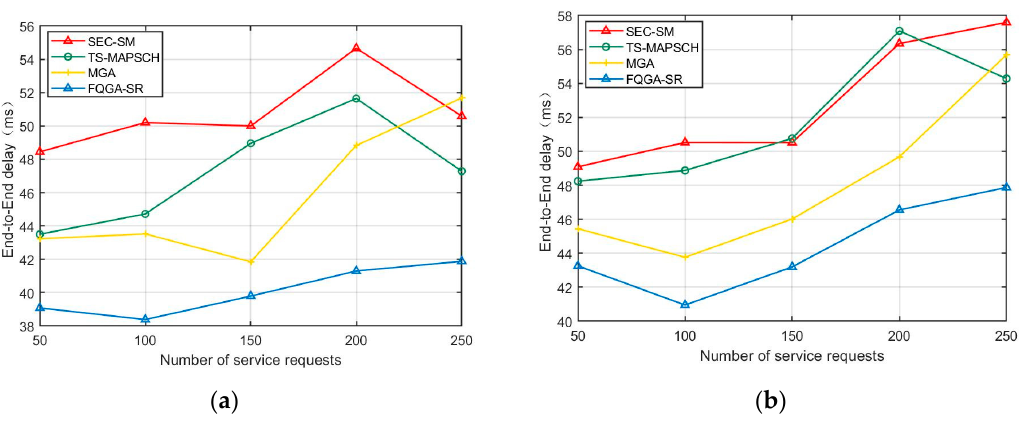
Figure 4. Comparison of end-to-end delay: ( a ) traffic load of 60%; ( b ) traffic load of